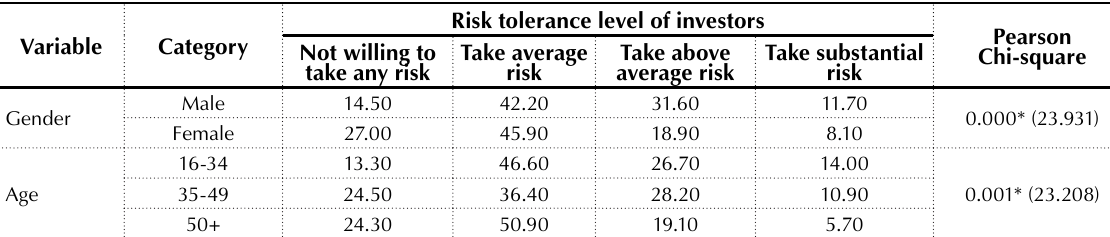
Table 3. Cross tabulation of investor risk tolerance of gender and age Variable